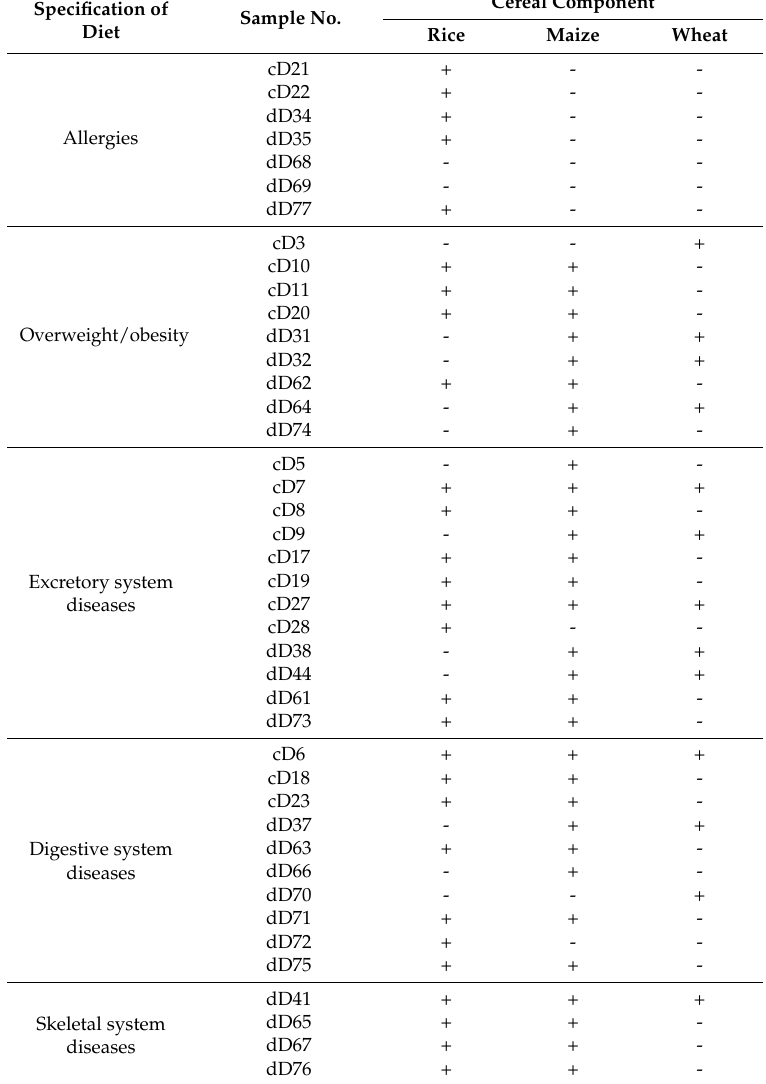
Table 1. Characteristics of the cereal components present in veterinary diets for dogs and cats. Specification of Sample Diet